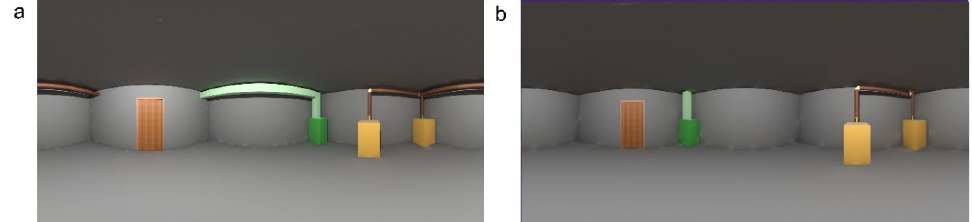
Figure 6. Expanded 360-degree spherical photo of the mechanical rooms: ( a ) Scenario A; ( b ) Sce- nario